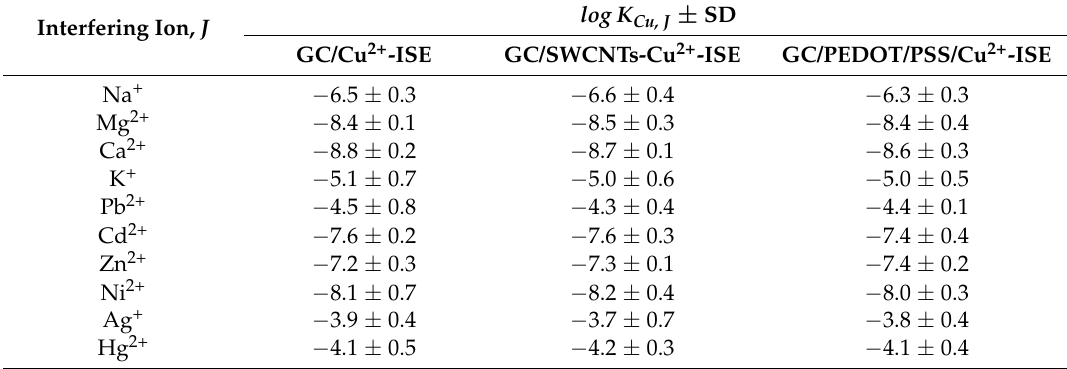
Table 2. Potentiometric selectivity coefficients ( log K Cu, J ) ± SD obtained for the proposed sensors. Interfering Ion,